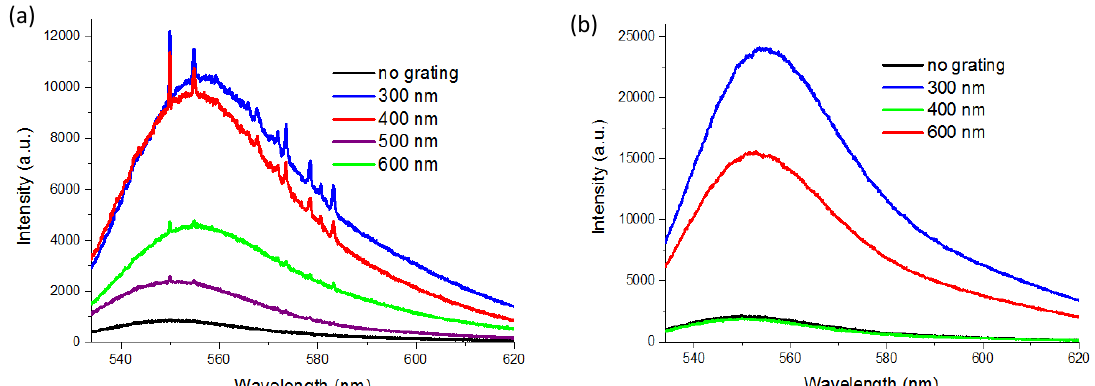
Figure 3. Raw data from ( a ) nonlift-off and ( b ) lift-off nanogratings of representative periods. The black curves are the spectra from substrates with no corrugated grating structure. Surface-enhanced Raman scattering (SERS) signal is only observable on the nonlift-off nanogratings. Prominent periodicity dependence of the Raman and fluorescence signals is manifested.